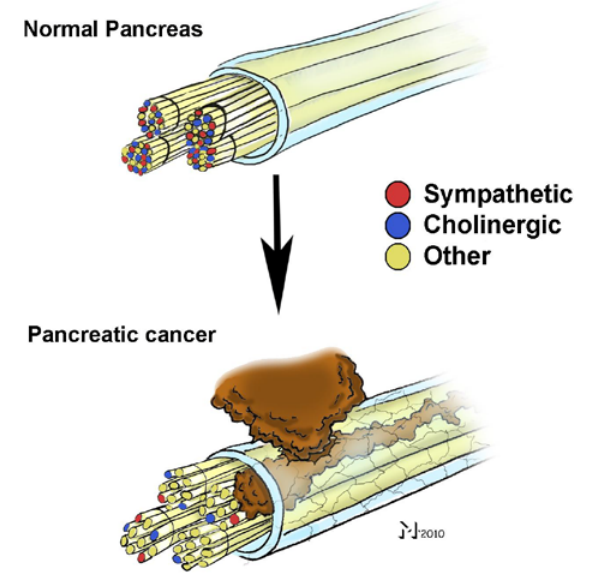
Figure 2. Neural invasion (NI) in pancreatic cancer (PCa) is associated with a “remodeling” of intrapancreatic nerves. Analysis of nerve fiber qualities in the hypertrophic, sprouting and invaded nerves in PCa revealed that the proportion of sympathetic and cholinergic nerve fibers in these nerves is much smaller than in normal pancreatic nerves. Therefore, the quality of the remaining fibers in these nerves remains to be